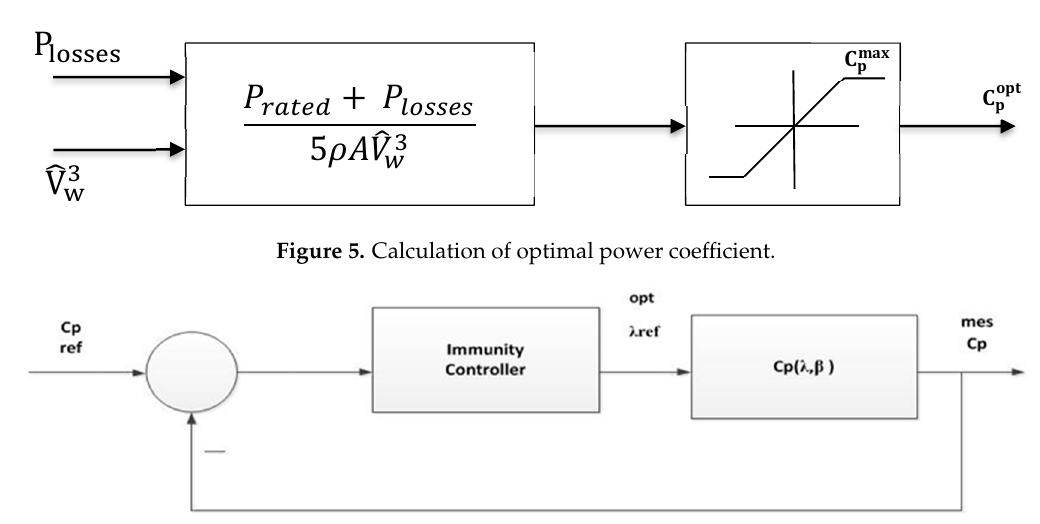
Figure 6. Structure of the Artificial Intelligent Eco-MPPT.